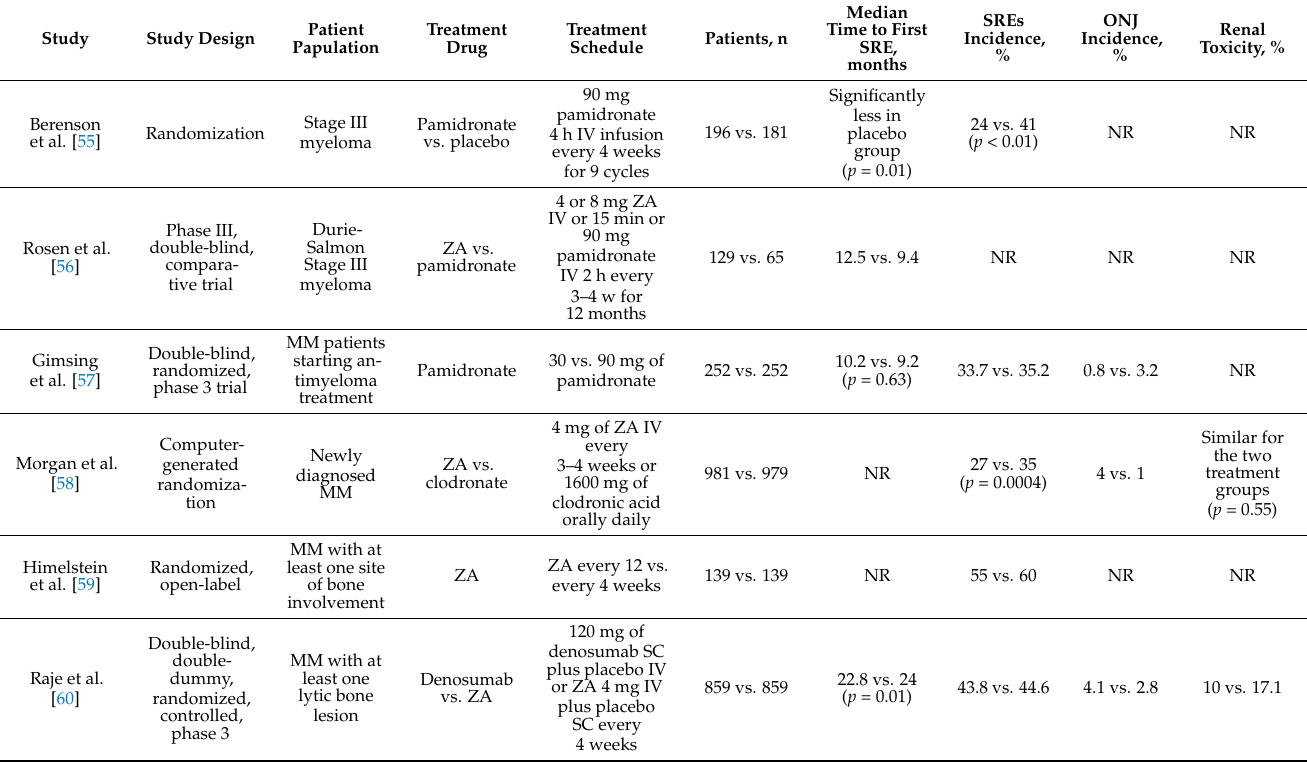
Table 1. Treatment of MM bone disease